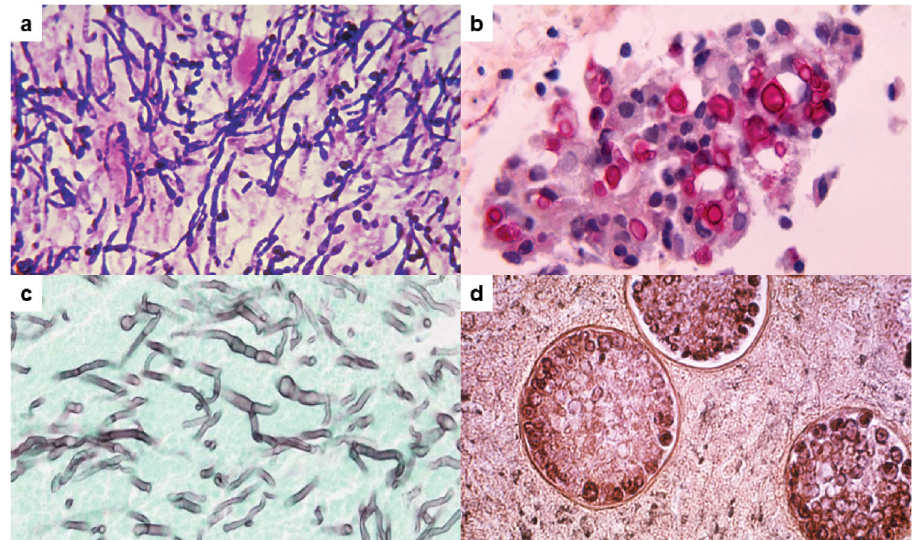
Fig. 2 Examples of the diversity in fungal morphology in human tissue from patients with mycoses. a Tissue Gram stain of C. albicans from a patient with endocarditis. Hyphae (elongated cells), pseudo-hyphae (sausage-shaped cells) and yeasts (oval cells, some with buds) stain deep purple. Candida cells average 2 – 8 microns in diameter. b Mucicarmine stain of C. neoformans in the lungs of a patient with pulmonary cryptococcosis. Budding yeast cells with capsules that stain rose red are present. Yeast cells average about 5 microns in diameter without capsule. Capsular thickness is variable, typically ranging from 1 to 10 microns. c Grocott ’ s methenamine silver stain of A. fumigatus from a patient with invasive pulmonary aspergillosis. Septate hyphae with “ Y ” -shaped branching that stain silvery black are present. Average